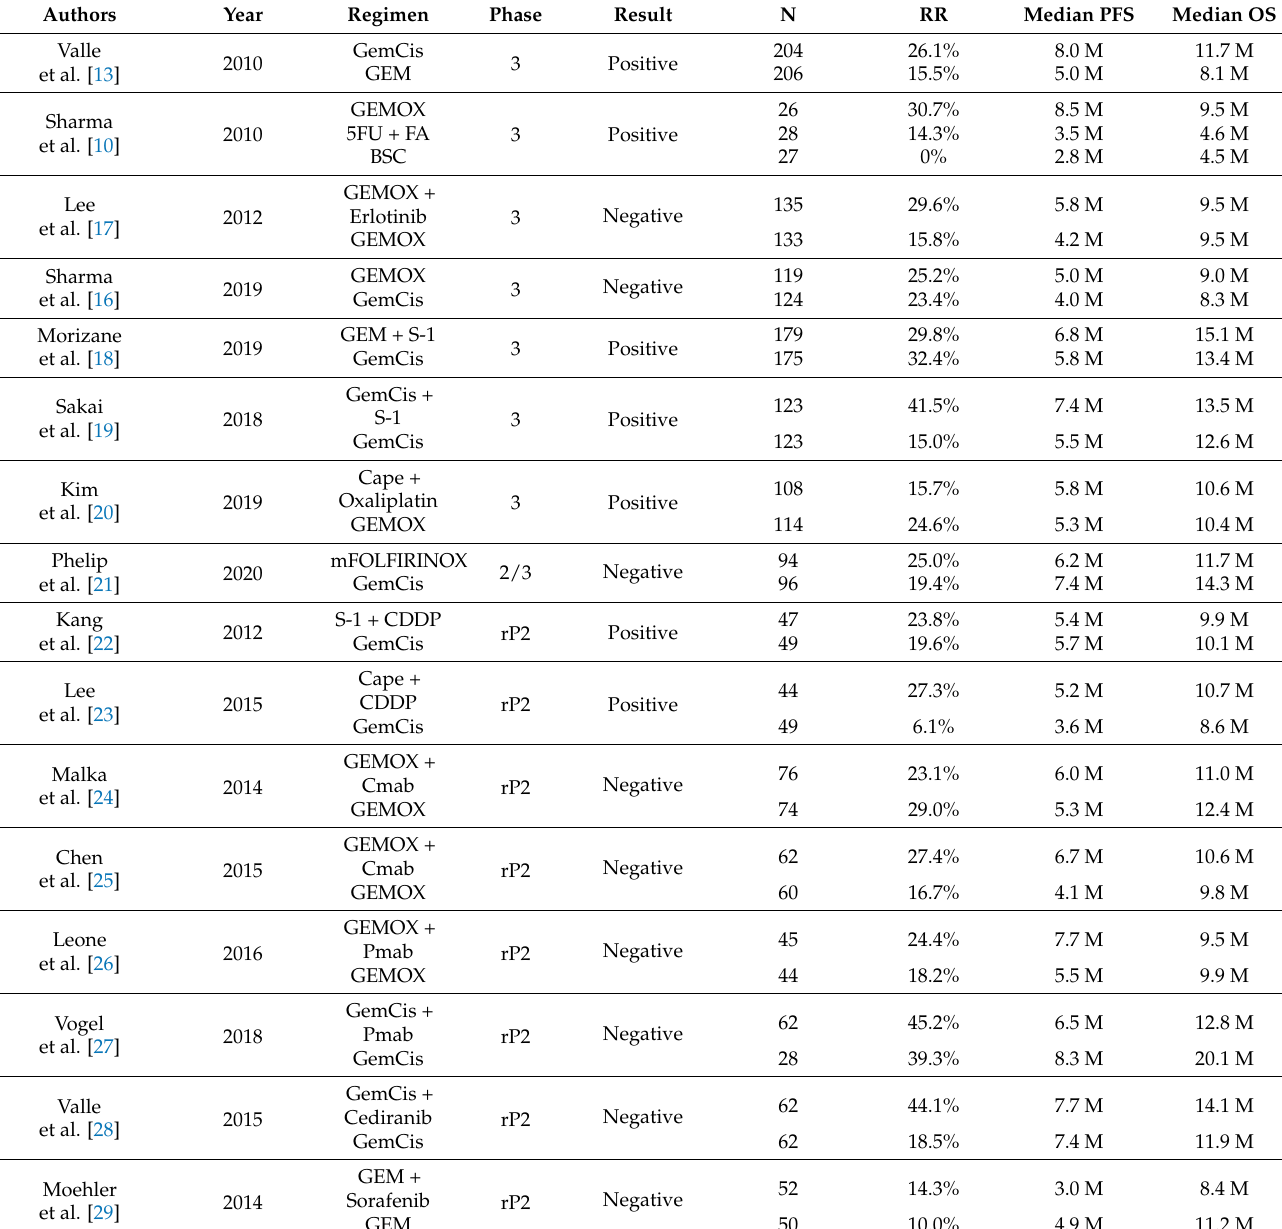
Table 1. Randomized controlled studies on first-line chemotherapy for advanced biliary tract